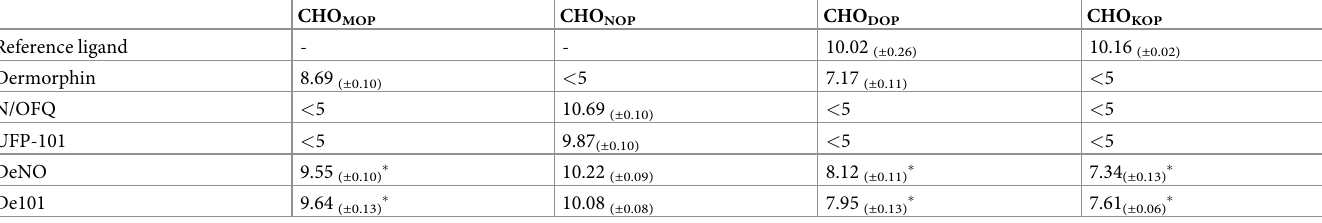
Table 1. The pK i values for both the reference ligands, Dermorphin, N/OFQ, UFP-101 and